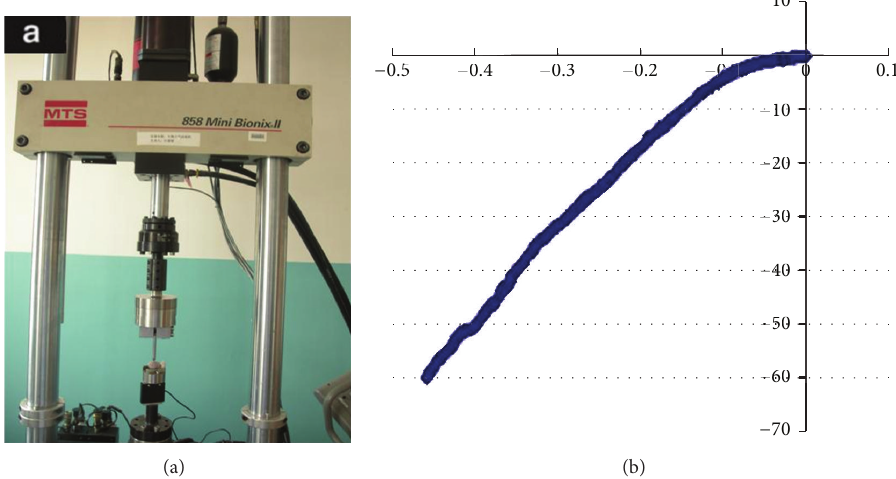
Figure 10: Biomechanical properties test: (a) device for mechanical testing, (b) load-displacement curve.